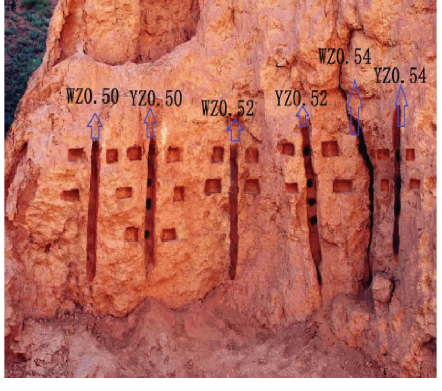
Figure 3: Experimental site.